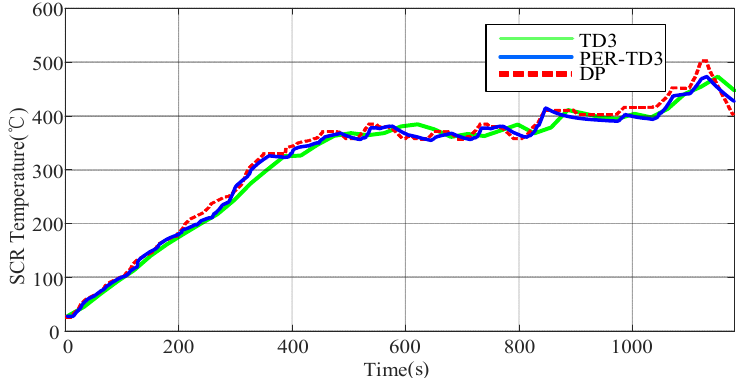
Figure 13 . SCR temperature of different strategies. Figure 13. SCR temperature of different strategies.